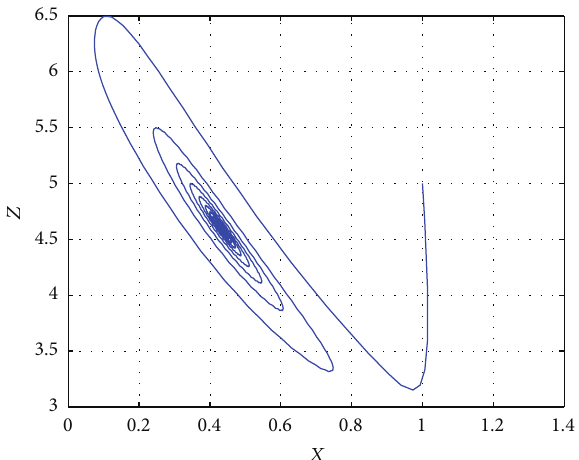
Figure 6: 𝑋𝑍 -plane projection of the solution for nonzero exoge- nous input ( 𝛾 = 1.25 ) with 𝑋(0) = 1 , 𝑌(0) = 1 , and 𝑍(0) = 5 ; parameter values are given in Table 1.